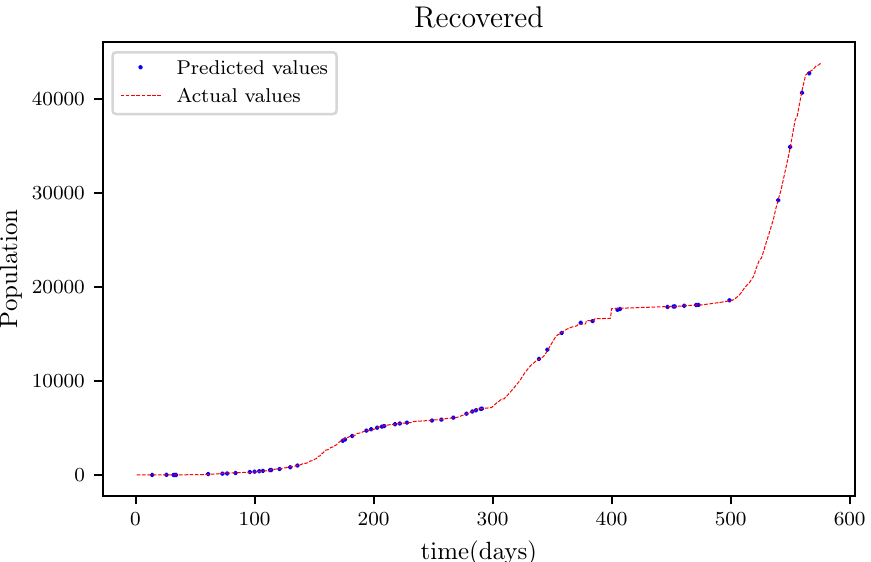
Figure 13. This graph shows a comparison of the predicted values of recovered population and the actual data of the recovered population for a 130 data points.